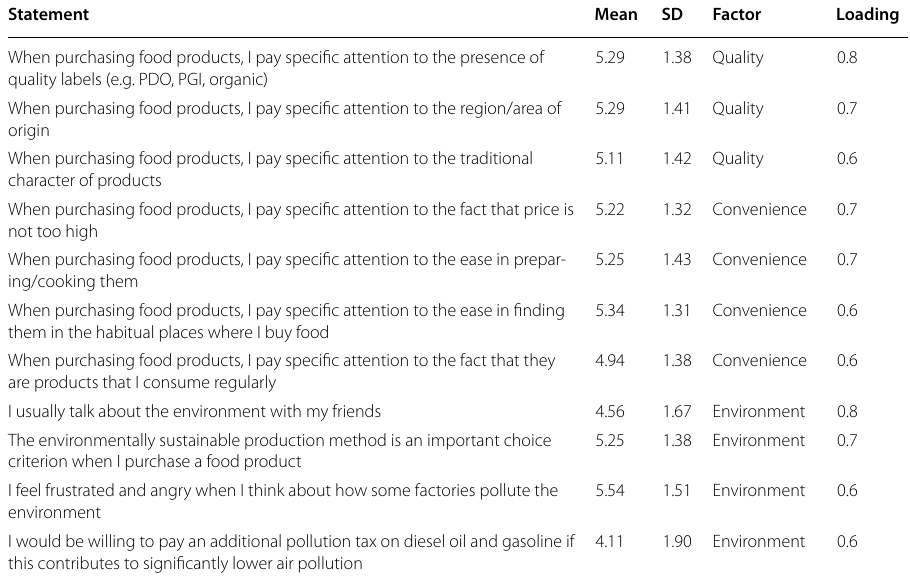
Table 9 Results of the exploratory factor analysis on 11 attitude statements (seven-point scale)